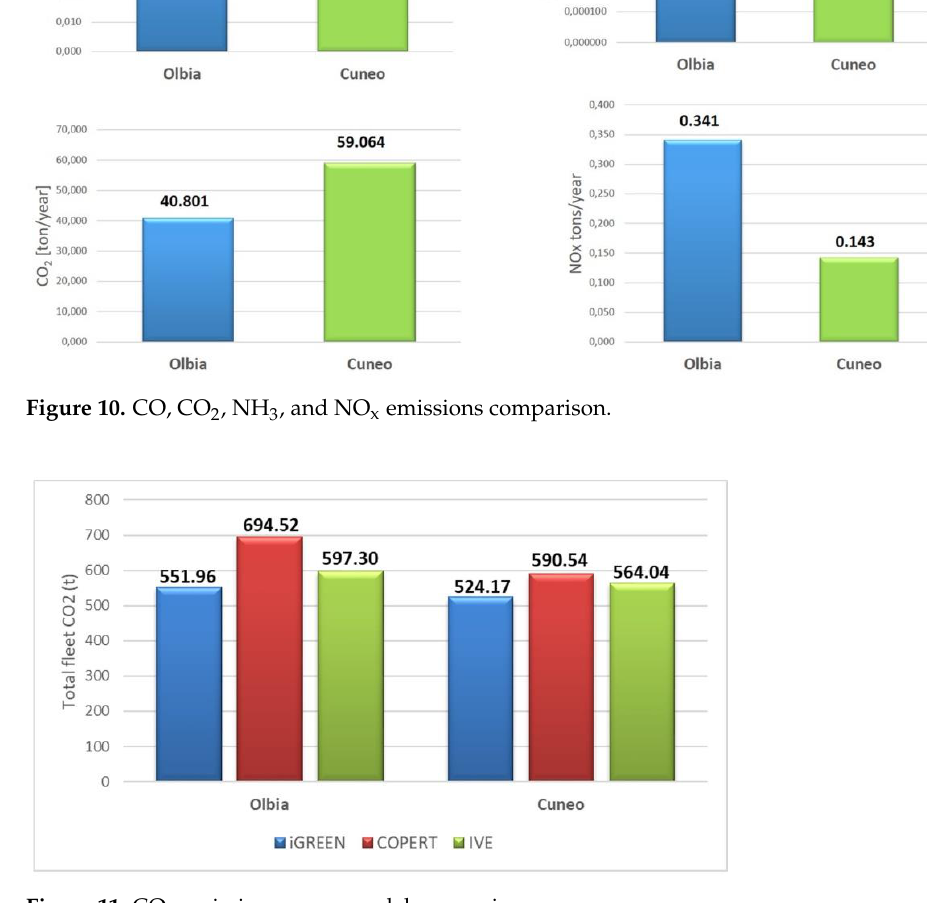
Figure 11. CO 2 emissions, cross-model